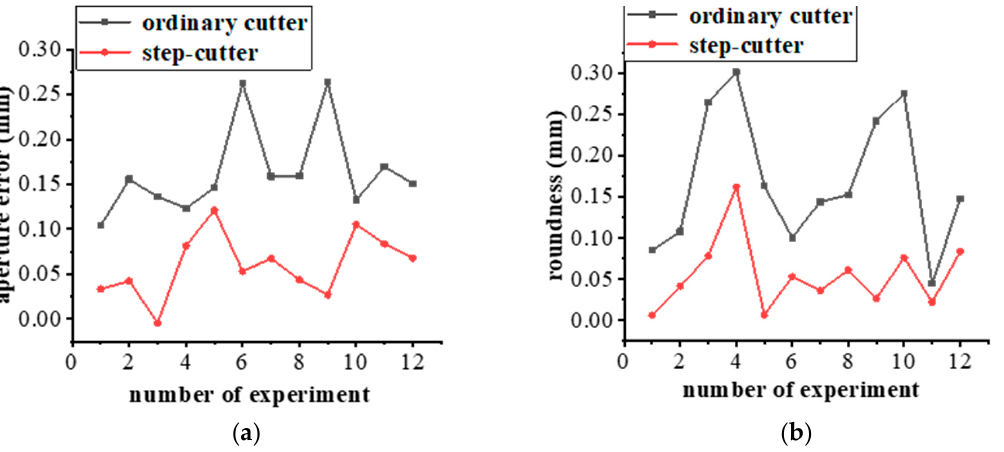
Figure 19. Accuracy comparison of helical milling hole between ordinary cutter and step-cutter. ( a ) Aperture error. ( b ) Roundness.